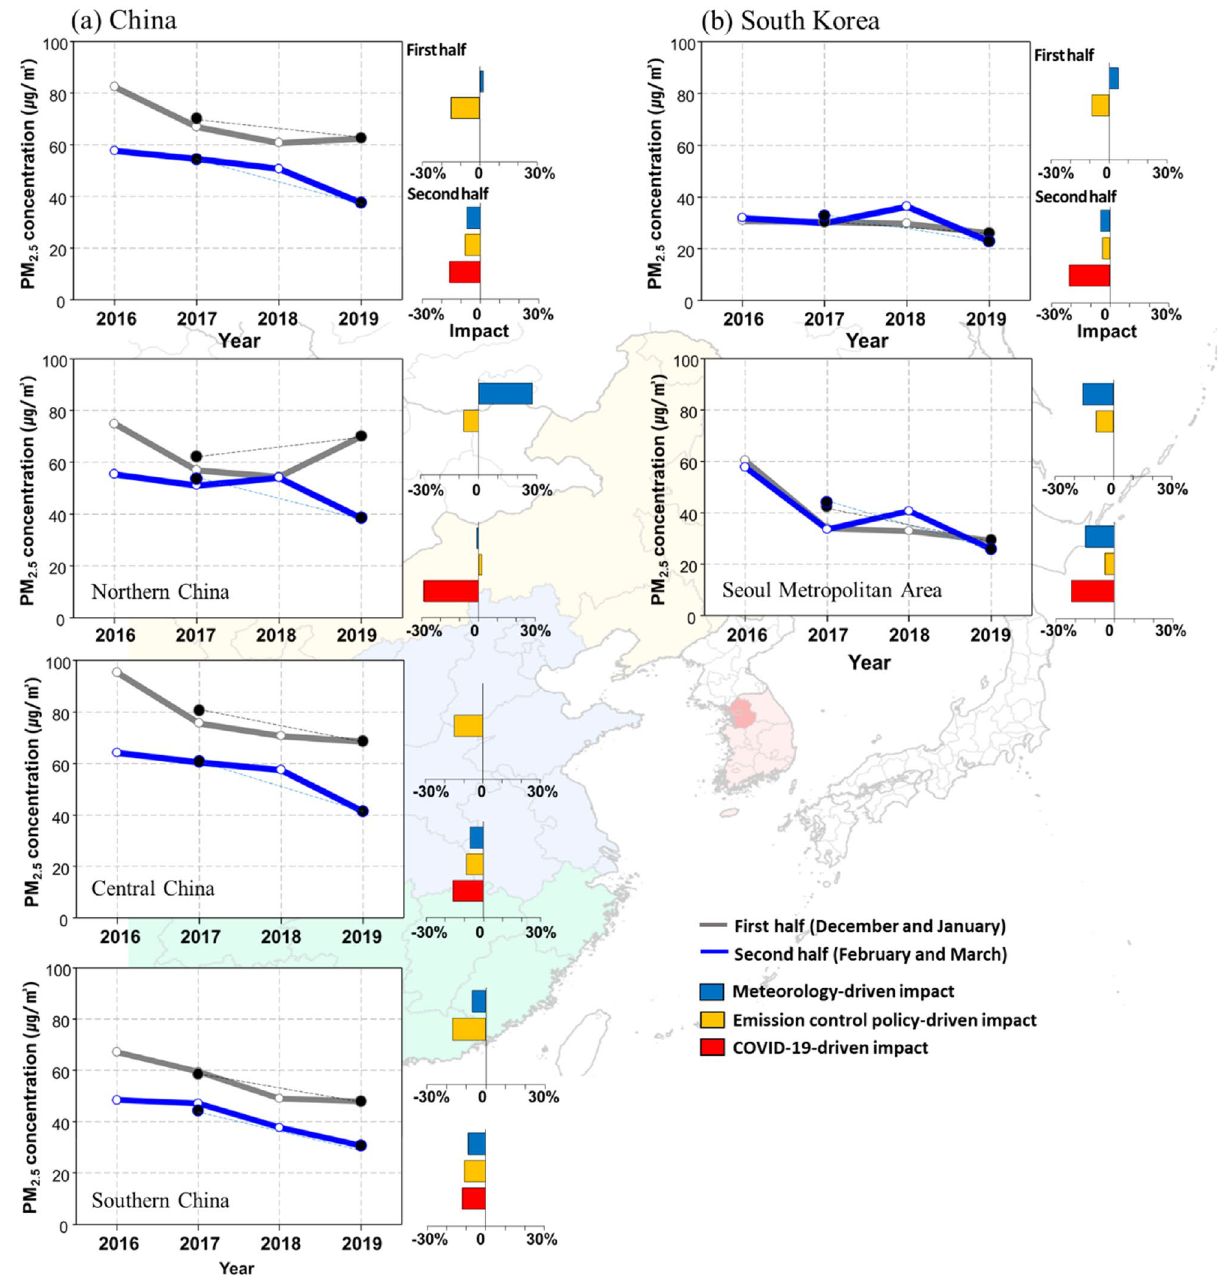
Figure 3. Trends of period-mean PM 2.5 concentrations and meteorology, and emission control policy and COVID-19-driven impacts on the change of PM 2.5 concentrations in the first half (December and January) and the second half (February and March) during 2016–2019 over China (including North, Central and South China) and South Korea (including SMA). The gray and blue lines indicate the PM 2.5 trends in the first and second halves, respectively. The black dots are the averaged PM 2.5 concentrations in the non-COVID-19 period (2016–2018) and the COVID-19 period (2019). The blue, yellow, and red bars indicate the meteorology, emission control policy and COVID-19-driven impacts on PM 2.5 changes. The yellow, blue, and green regions are Northern, Central, and Southern China. The red region is SMA in South Korea (pink). The map was generated using Interactive Data Language version 8.7.0 (Harris Geospatial Solutions, http://harri sgeos patia l.com) with Global Administrative Areas (http://gadm.org) map